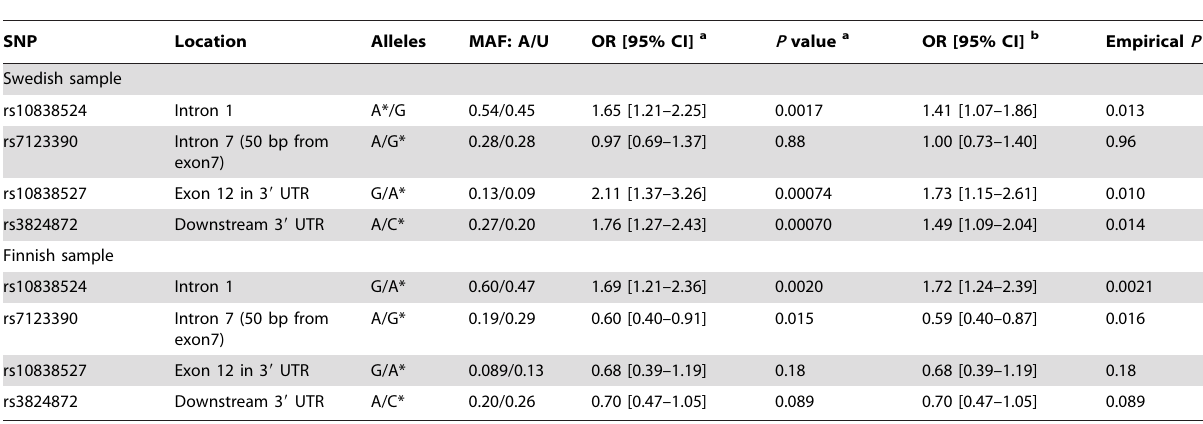
Table 1. SNP allele frequency association